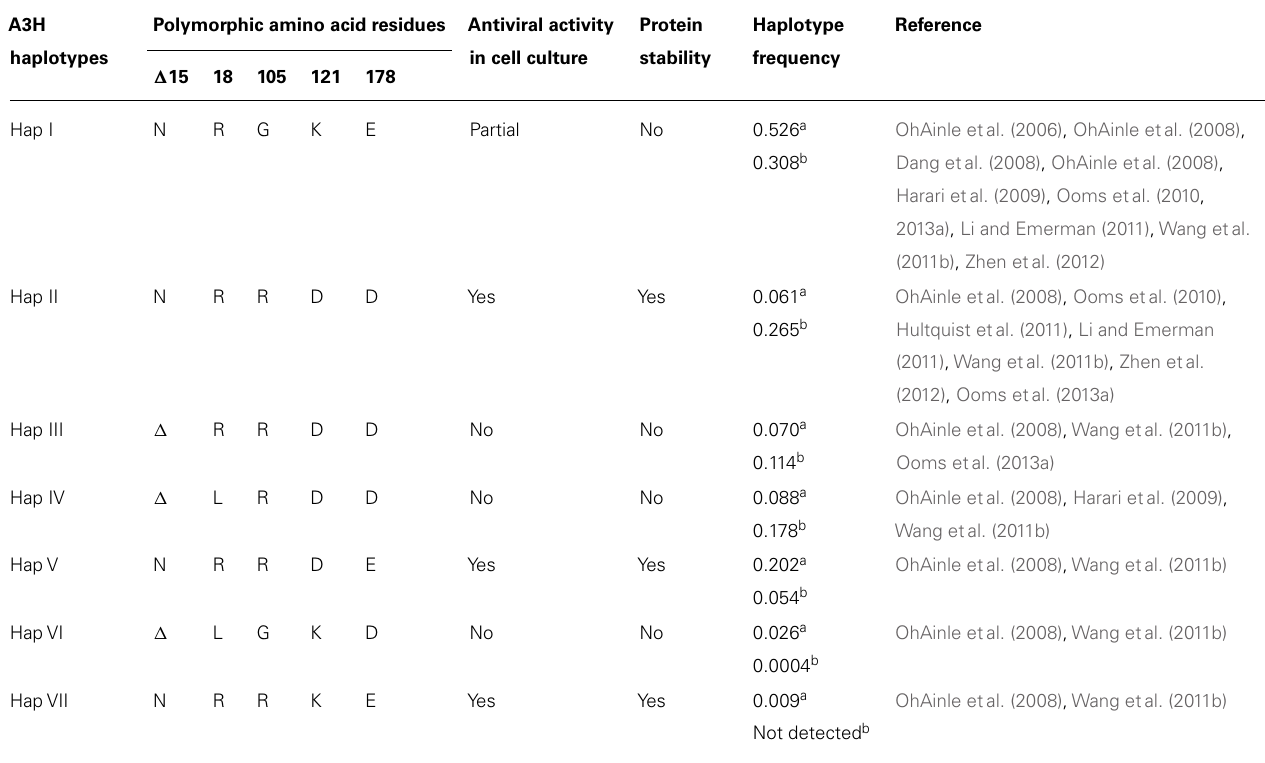
Table 1 | Summary ofA3H haplotype features.